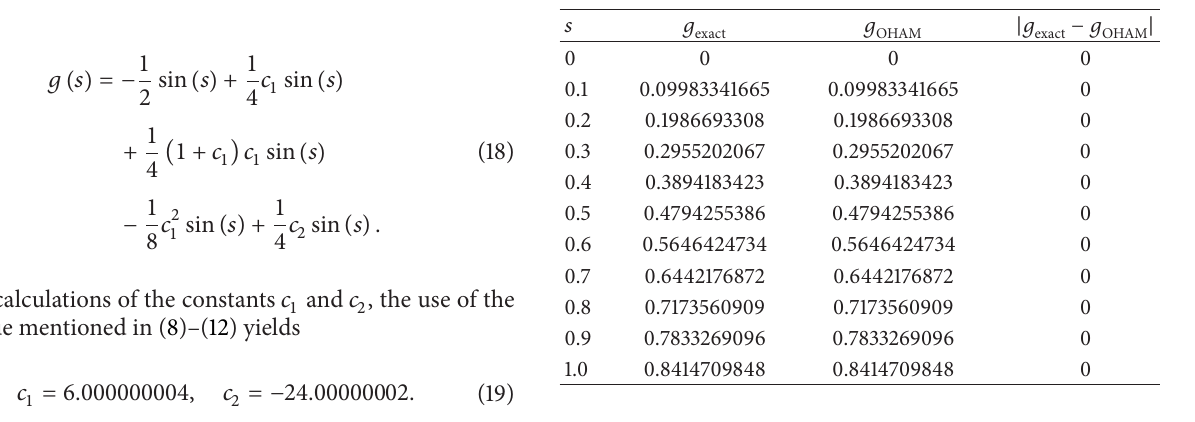
Table 1: Numerical results of Example